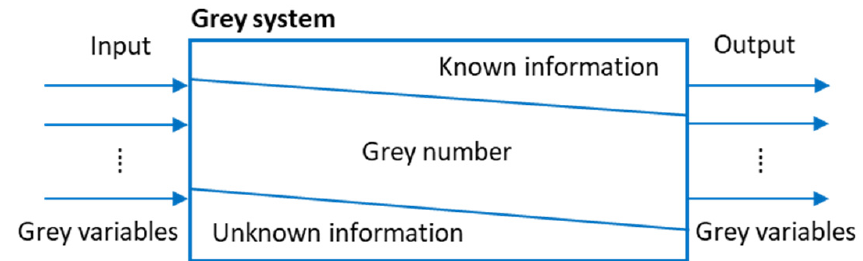
Figure 1. The research framework of this study.